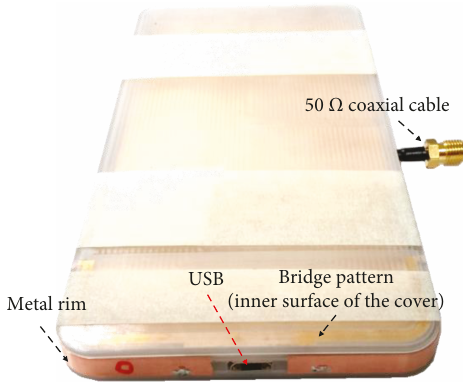
Figure 7: Photograph of the fabricated prototype containing the crossed-loop LTE antenna.